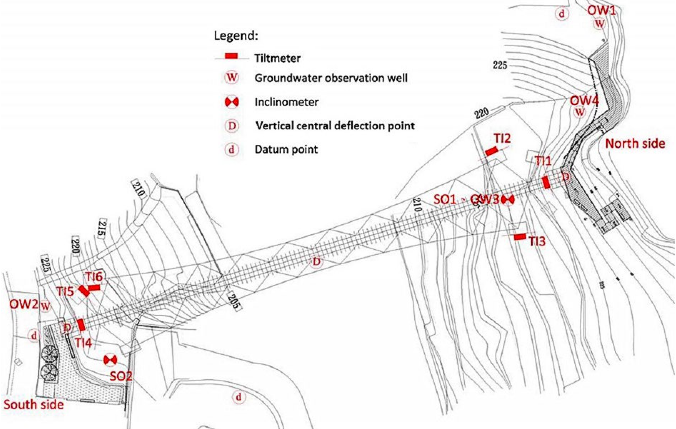
Figure 10. Location of monitoring system for suspension bridge and side